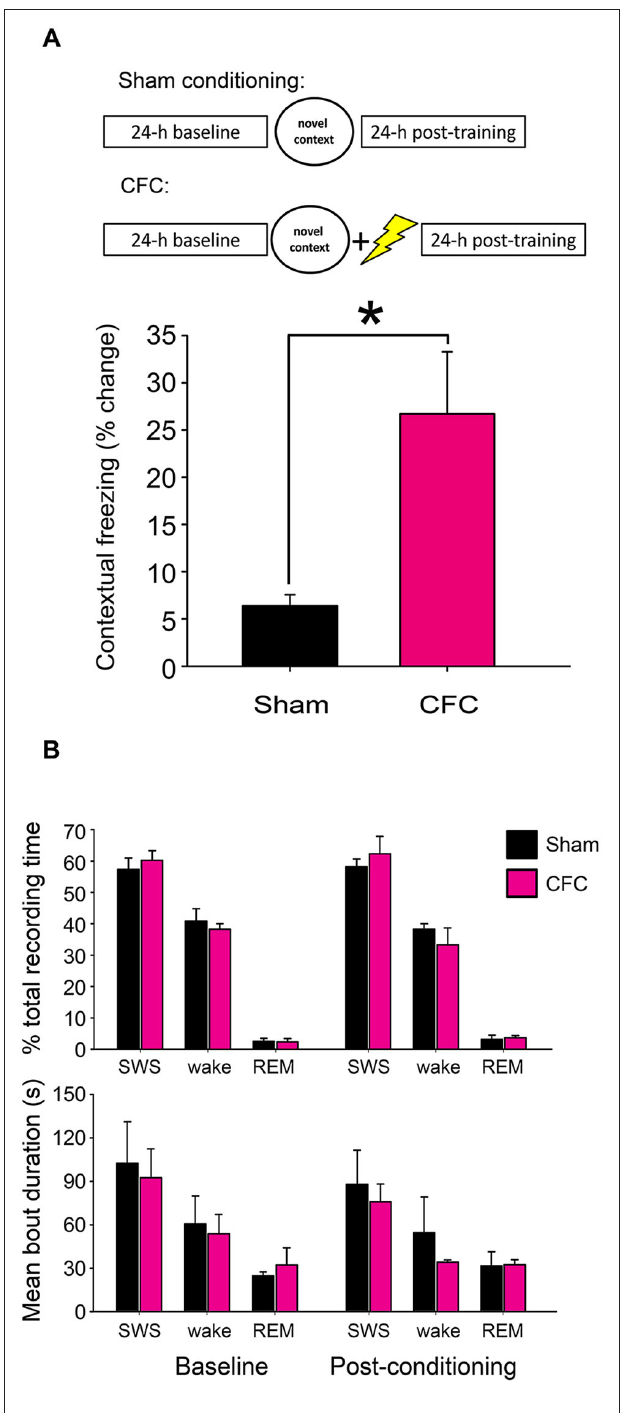
FIGURE 1 | CFC initiates fear memory formation without significantly altering sleep-wake behavior. (A) Experimental overview and quantification of context-specific freezing in Sham and CFC mice ( n = 6 per group). * indicates p < 0.05, Student’s t -test. (B) Sleep architecture in the 24 h following CFC was not significantly altered, either relative to pre-CFC baseline, or relative to the 24 h following Sham conditioning. Effects of group (Sham vs. CFC) and time relative to training (baseline vs. post-conditioning) on % total recording time or bout duration for each state, N.S ., two-way RM